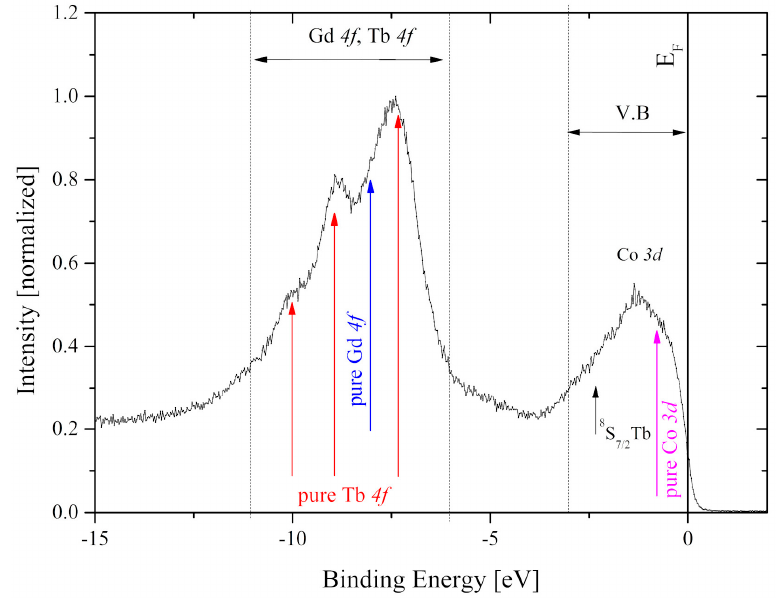
Figure 9. The XPS valence band of the Gd 0.4 Tb 0.6 Co 2 . The spectrum is normalized to the maximum intensity in this energy range. Vertical arrows show the positions of spectral lines observed in elemental Gd, Tb, and Co.